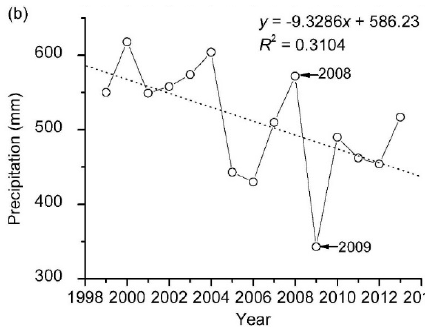
Figure 6. Changes in annual mean temperature ( a ) and annual precipitation ( b ) within the YZR basin from 1999 to 2013.